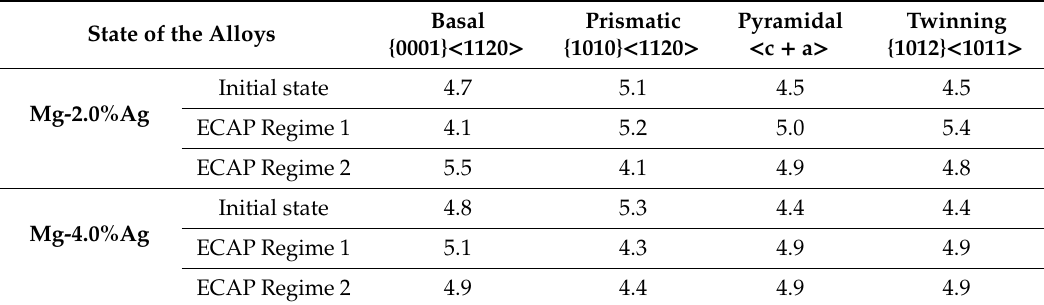
Table 3. Orientation factors for deformation systems of the alloys